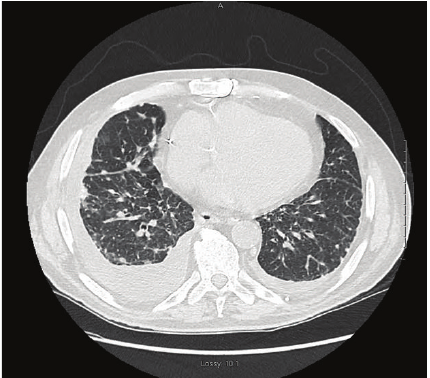
Figure 2: Chest CT showed moderate-sized bilateral pleural effu- sion and thickening with pulmonary nodules. There is mild inter- stitial fibrosis. There are multiple bilateral intrapulmonary nodules seen. Some of the nodules are pleural-based. A few nodules do have a small amount of associated calcification.